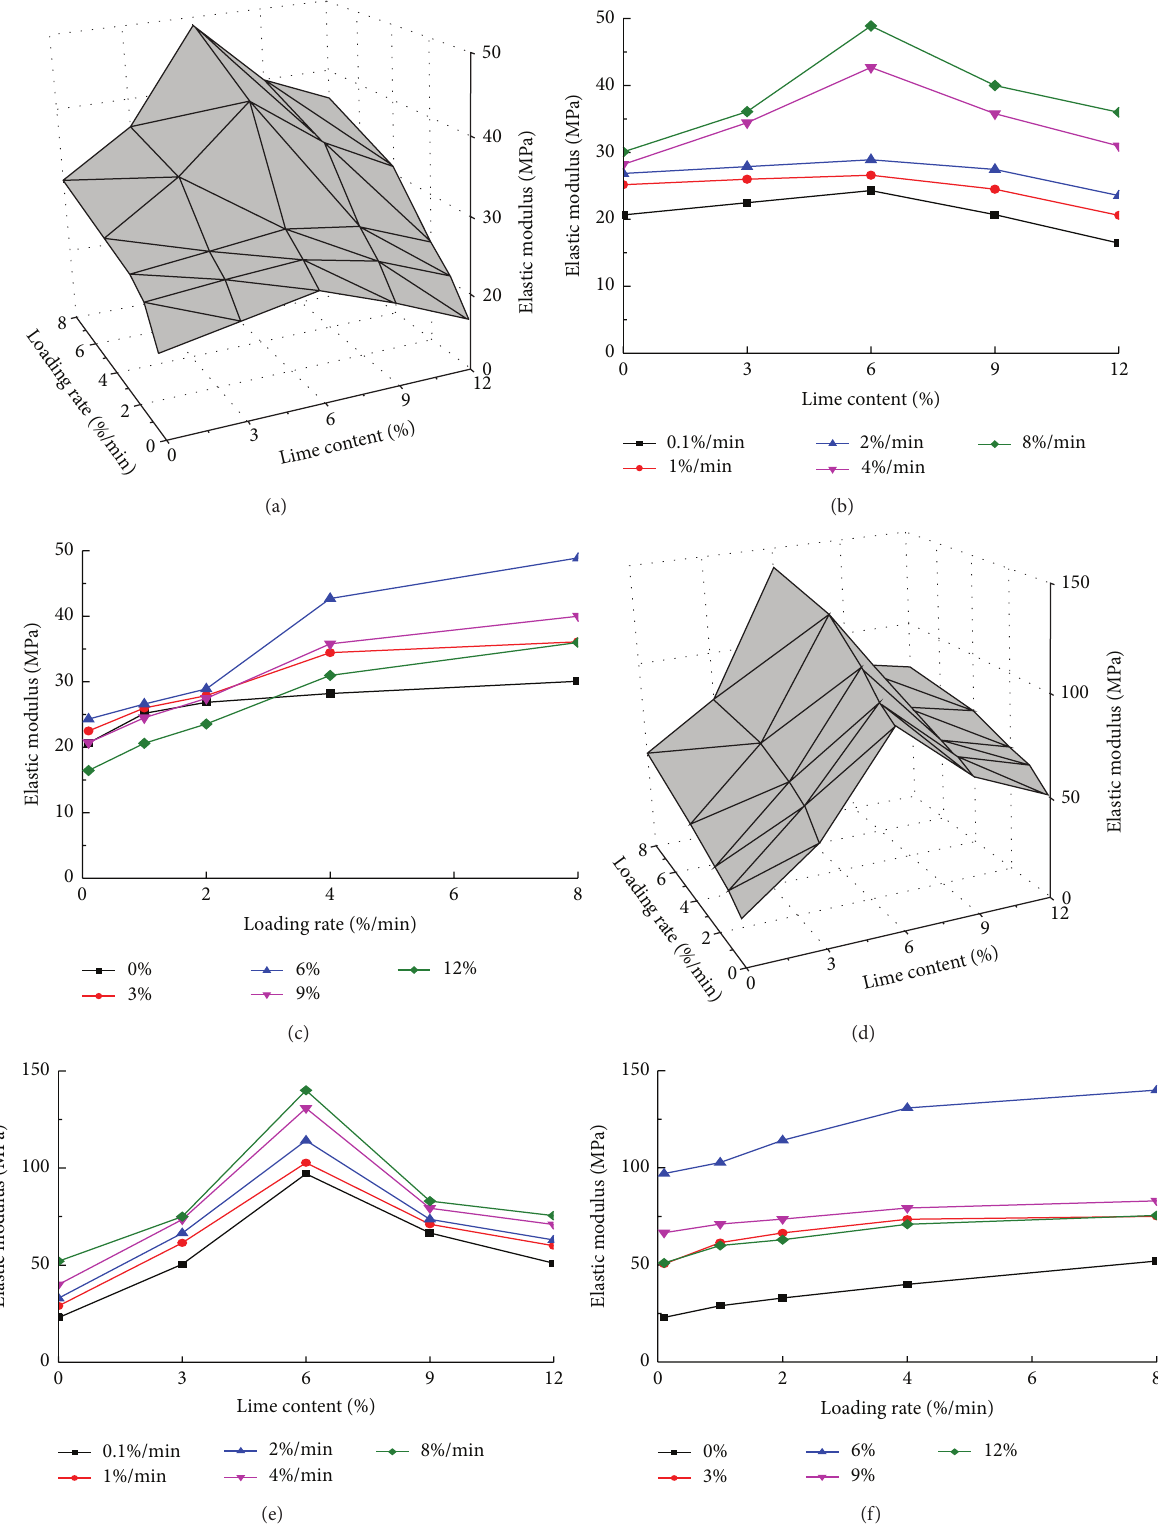
Figure 5: Relation between elasticity modulus and lime content and loading rate of (a) modulus of elasticity three-dimensional curved surface (7 days), (b) modulus of elasticity lime content (7 days), (c) modulus of elasticity loading rate (7 days), (d) modulus of elasticity three-dimensional curved surface (21 days), (e) modulus of elasticity lime content (21 days), and (f) modulus of elasticity loading rate (21